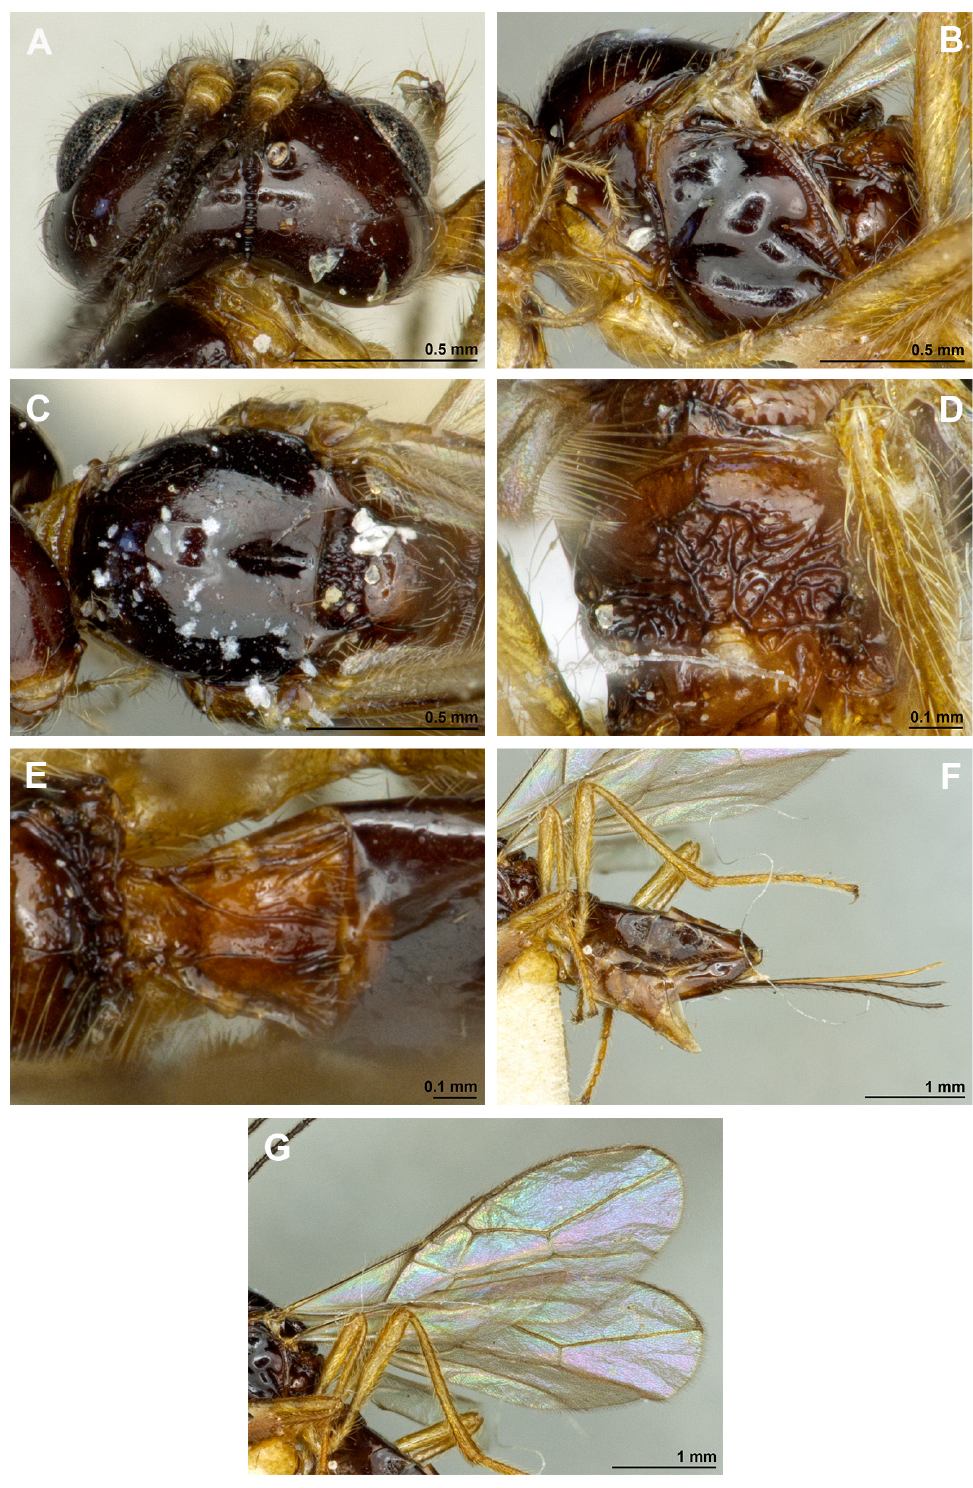
Fig. 57. Asobara somertensis Peris-Felipo, sp. nov., ♀, holotype (BMNH 1931-37). A . Head, dorsal view. B . Mesosoma, lateral view. C . Mesoscutum, dorsal view. D . Propodeum, dorsal view. E . First metasomal tergite, dorsal view. F . Hind leg, metasoma and ovipositor, lateral view. G . Fore and hind